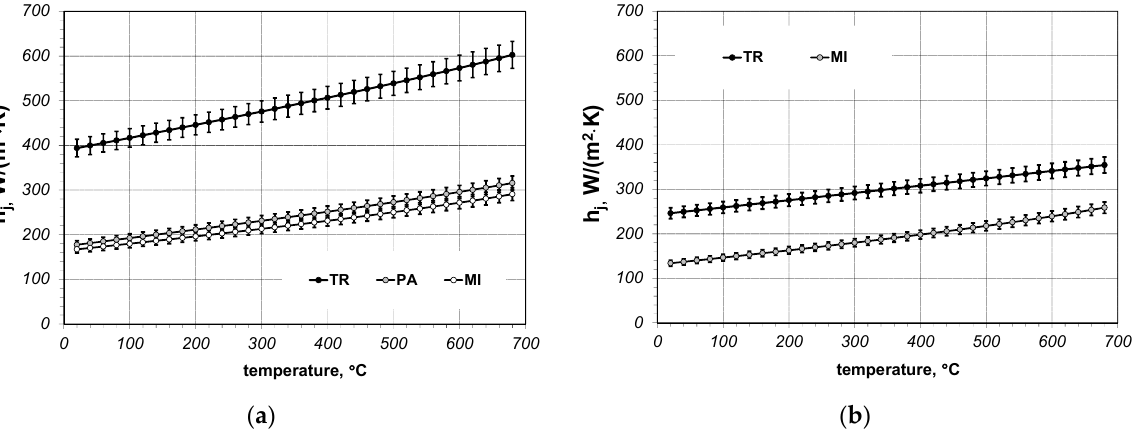
Figure 6. Calculated values of the joint conductance: ( a ) results obtained for samples made of 5 × 20 mm bars; ( b ) results obtained for samples made of 10 × 40 mm bars.